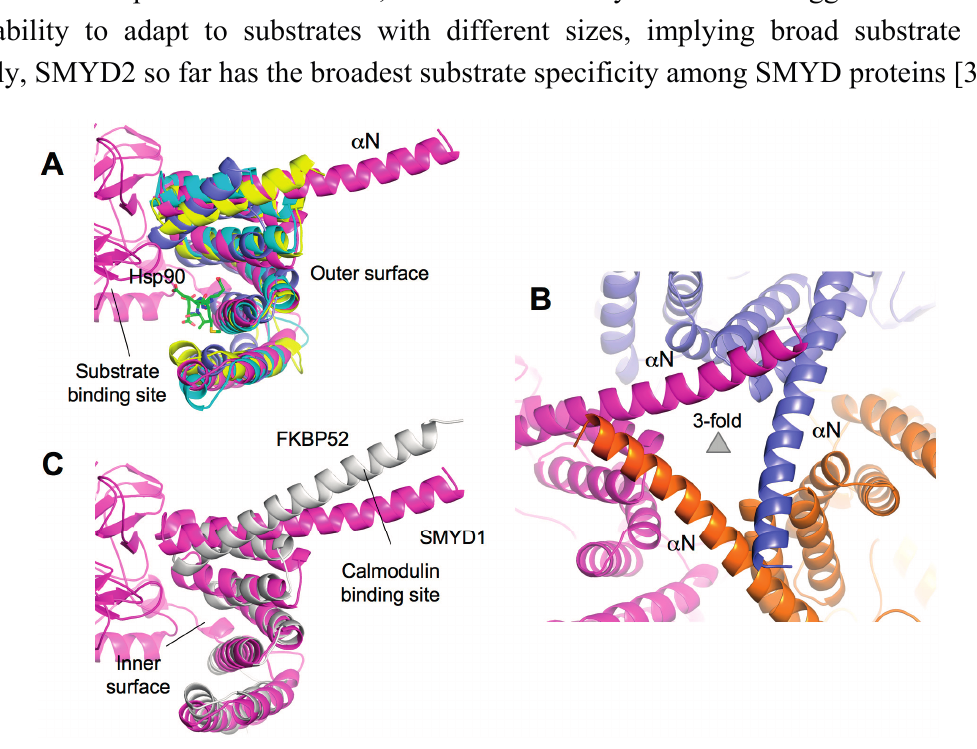
Figure 6. TPR-like C -terminal domain (CTD). ( A ) Structural superposition of the CTD domains of SMYD and TPR domain of Hop1 (PDB code: 1ELR). SMYD proteins are represented by ribbons and colored according to the scheme in Figure 1C. The Hop1 TPR domain is shown in blue. Hsp90 peptide bound to Hop1 is depicted by balls-and-sticks; ( B ) Crystal lattice of SMYD1 shows the involvement of the protruding C -terminal α -helix in the crystal packing; and ( C ) Structural superposition of the CTD domain of SMYD1 and TPR domain of FKBP52 (PDB code: 1QZ2). SMYD1 is colored in purple and FKBP52 in